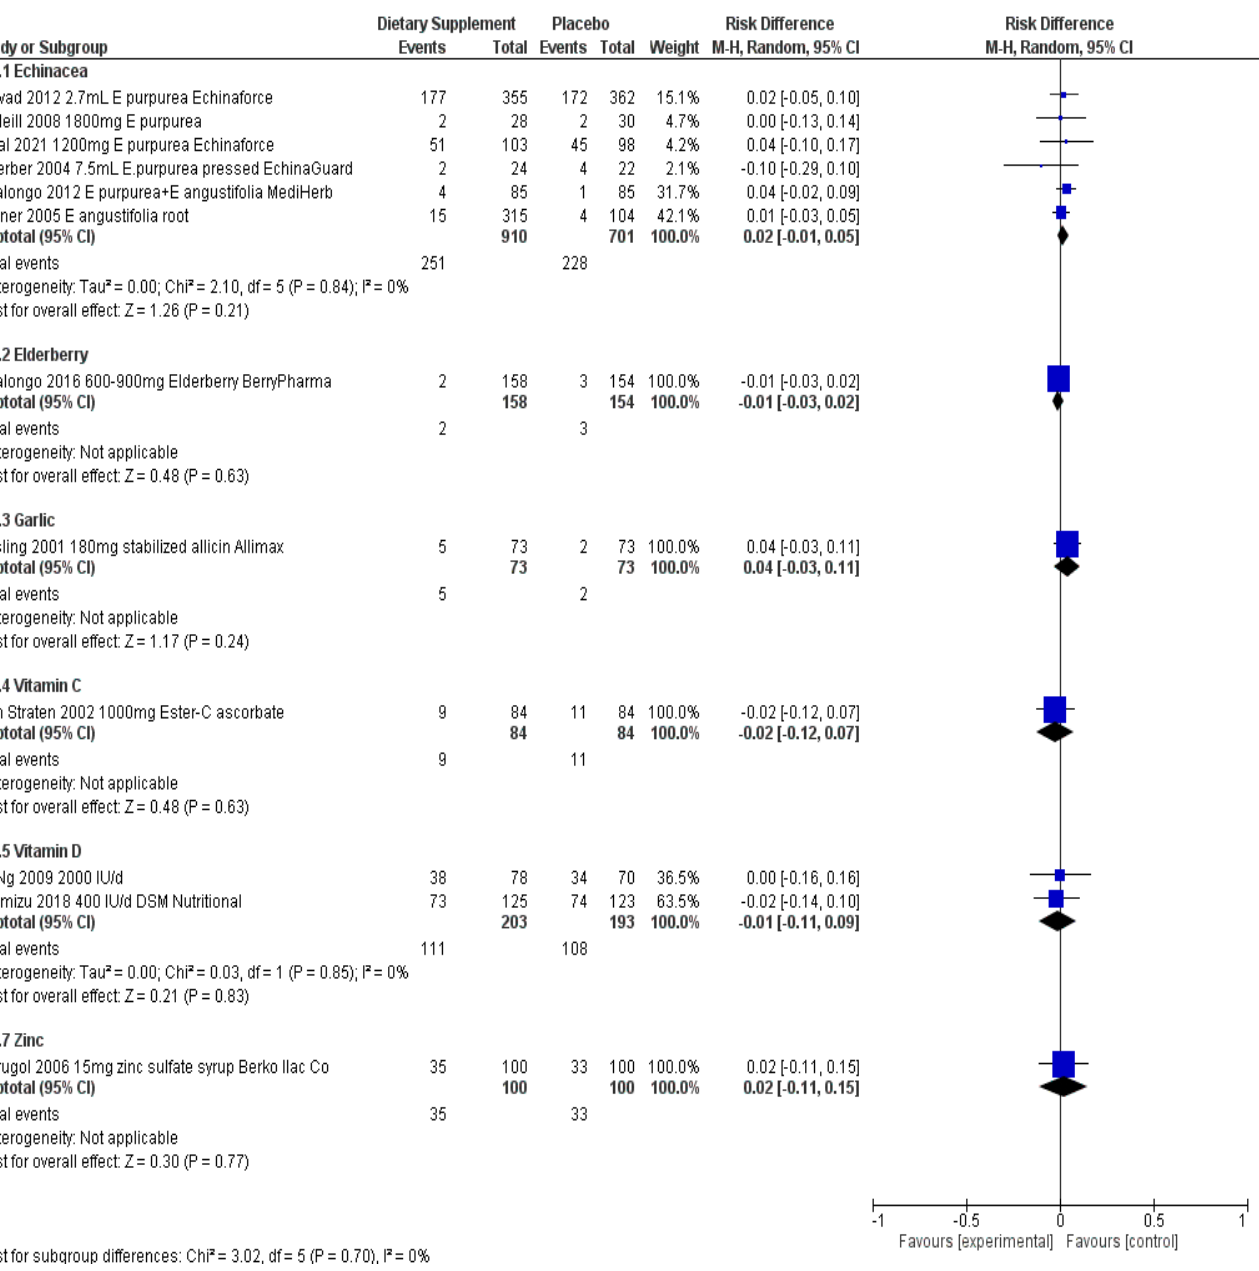
Figure 4. Analysis 1.4 Adverse events experienced by participants.